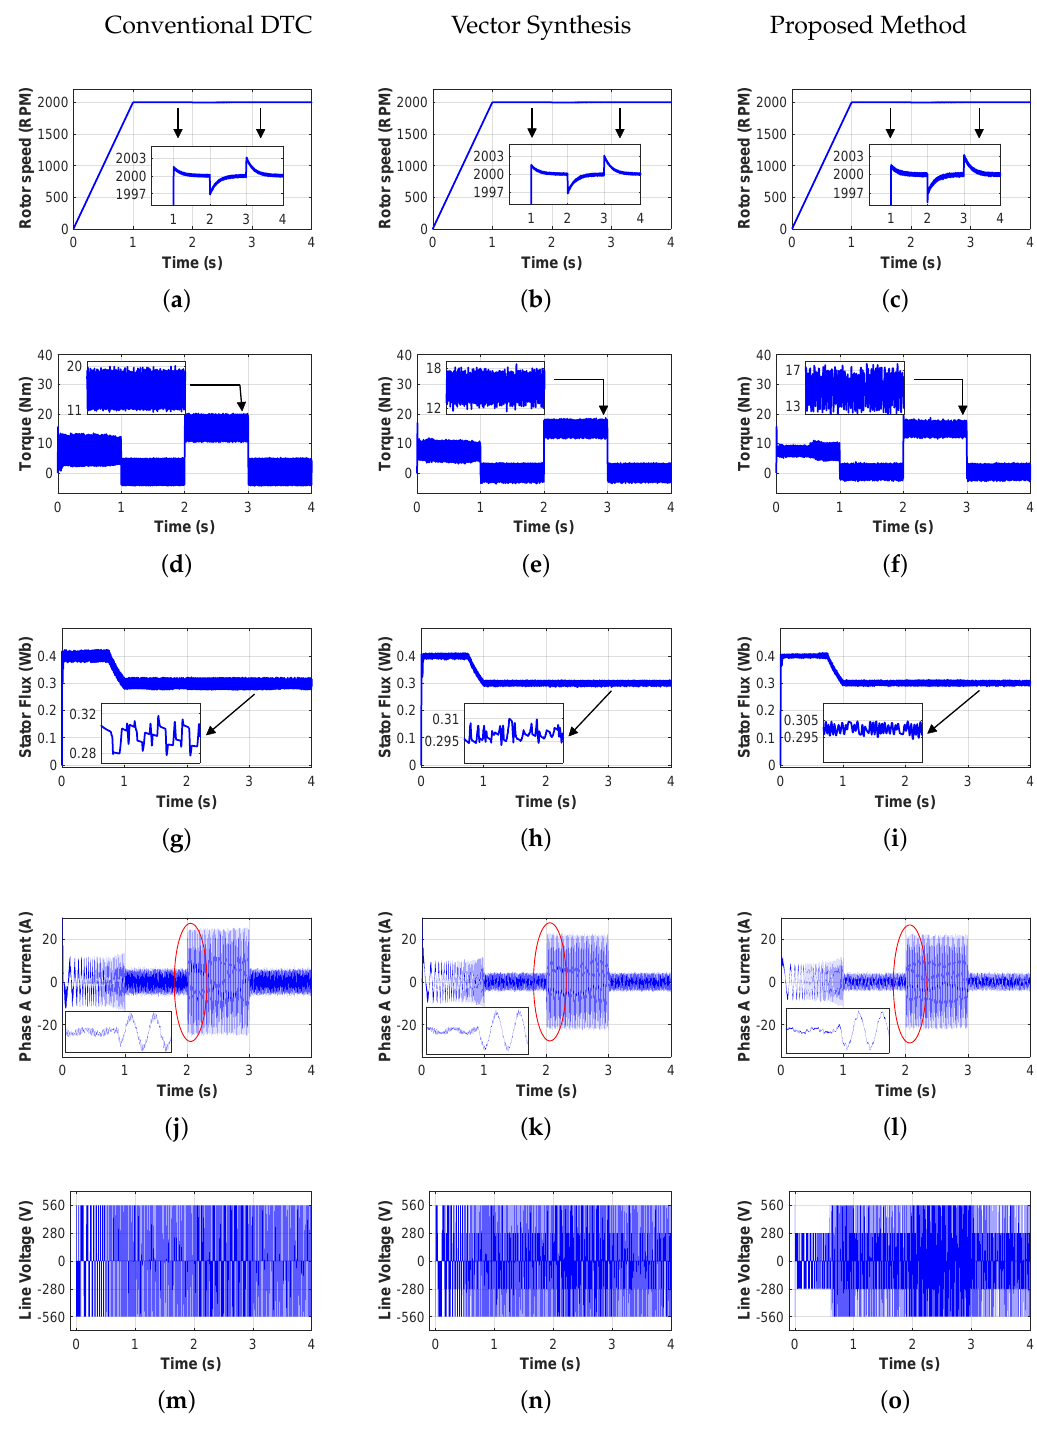
Figure 10. Simulation results for 2000 rpm under 15 N · m load torque disturbances: ( a – c ) rotor speed response; ( d – f ) motor torque; ( g – i ) stator flux; ( j – l ) input current; ( m – o ) line